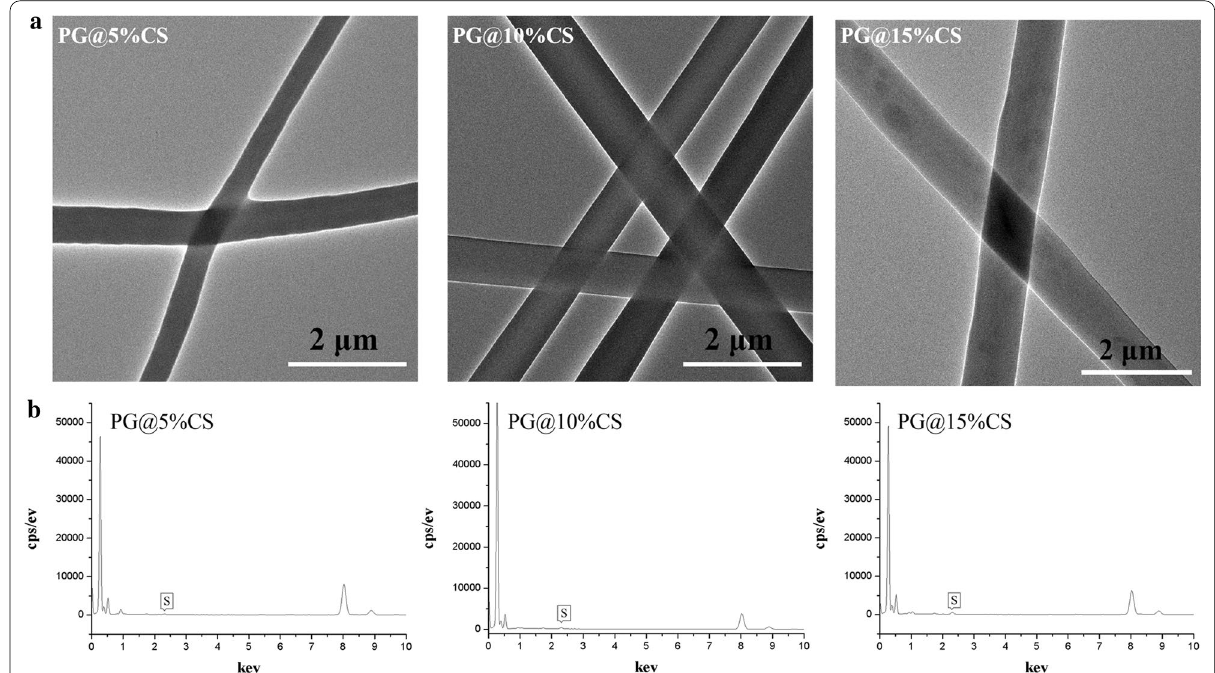
Fig. 3 TEM images ( a ) and EDX elemental analysis of CS@PG electrospun scaffolds at different ratios of CS, i.e., PG, 5%CS@PG, 10%CS@PG, and 15%CS@PG